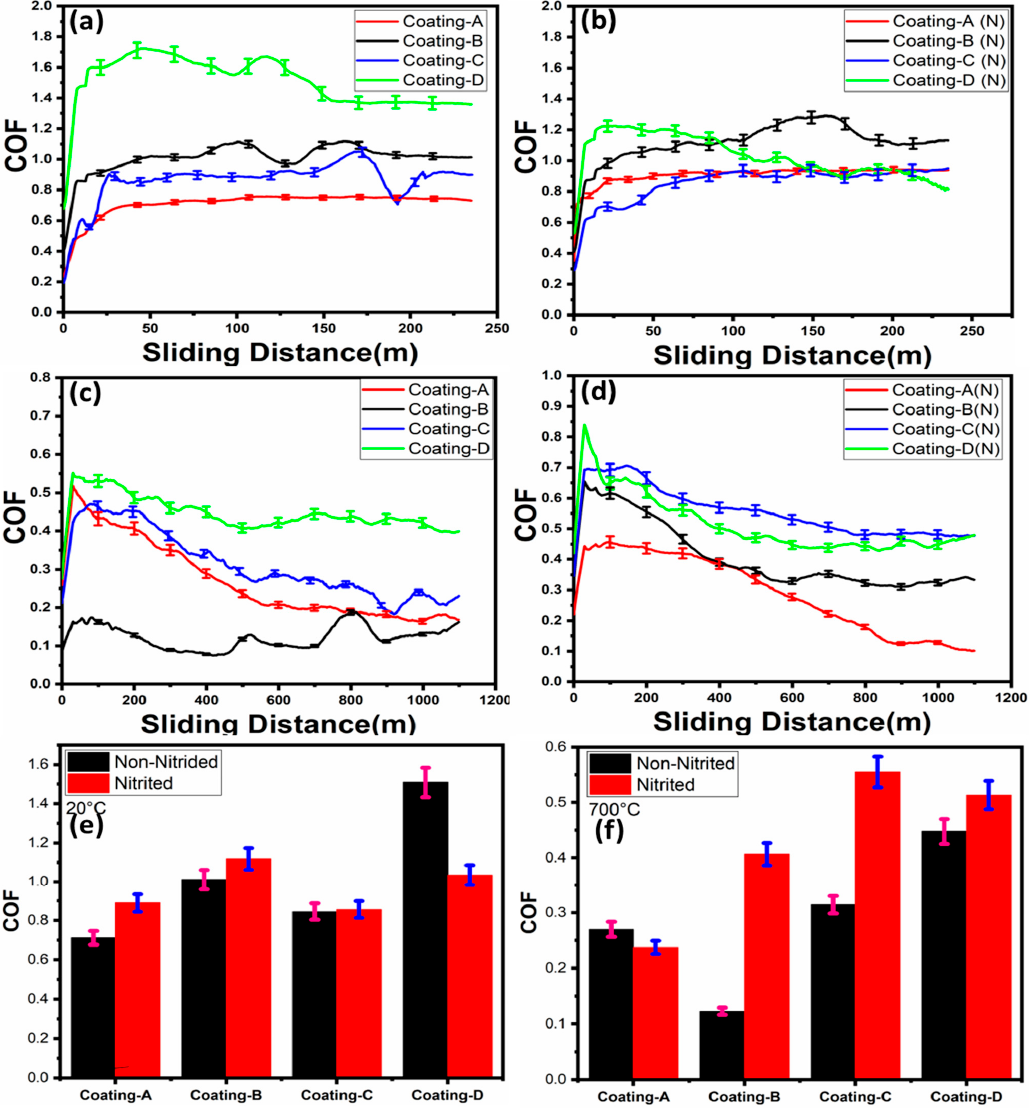
Figure 8. Friction coefficients of the coatings: ( a ) at ambient temperature (20 °C) on non-nitrided steel, ( b ) at ambient temperature (20 °C) on nitrided steel, ( c ) at elevated temperature (700 °C) on non-nitrided steel, ( d ) at elevated temperature (700 °C) on nitrided steel, ( e ) average COFs at 20 °C, ( f ) average COFs at 700 °C. Even if the nanostructured layers have enhanced mechanical characteristics at room temperature, these layers change as the temperature rises due to recovery, recrystallization, and grain development processes. [42]. The average COFs of the tribometer tests with three repetitions were shown in Figure 8e,f. Coating C had lower COFs on nitrided or non-nitrided steel than the other coatings, whereas coating D had the highest average COF of approximately 1.5 at 20 °C. However, coating B showed the lowest COF on non-nitrided steel, with an average COF of 0.12 at 700 °C (see Figure 8f).